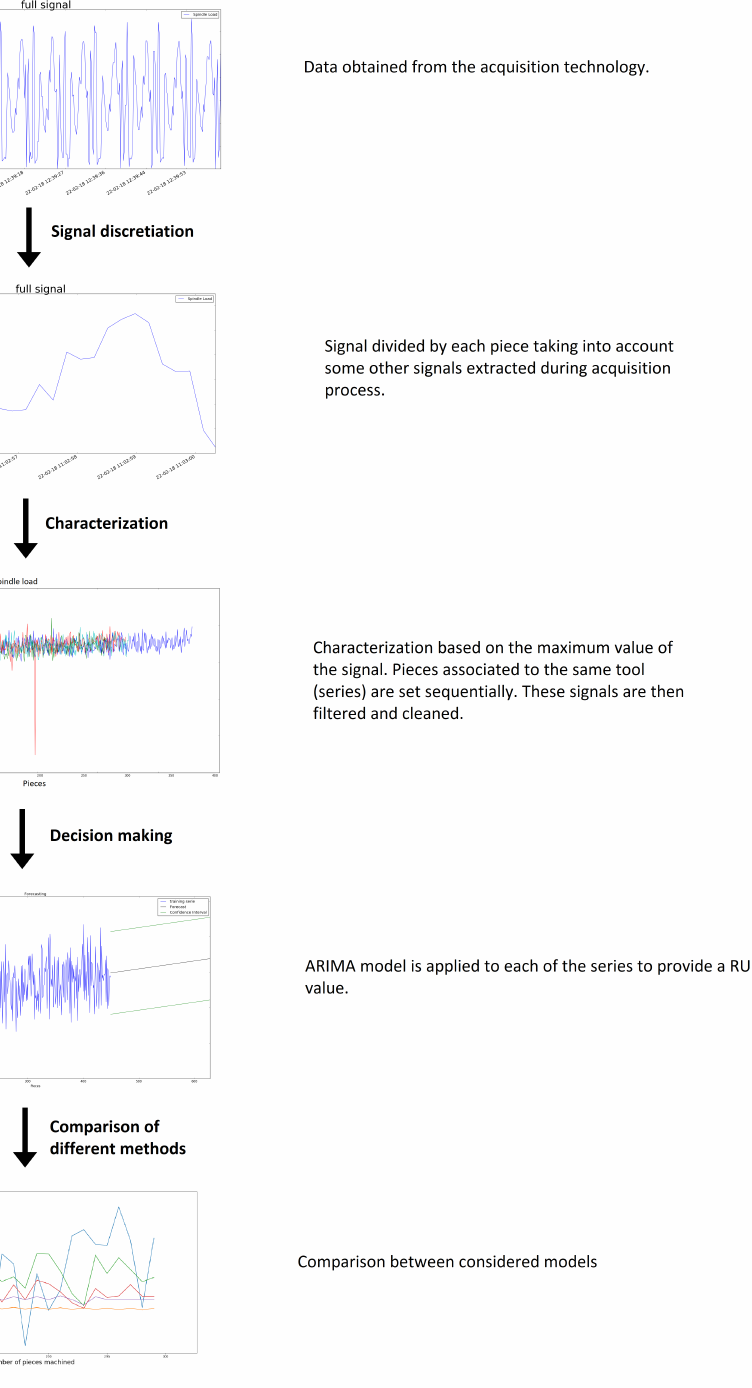
Figure 7. Flowchart of the main steps of the methodology exposed in this